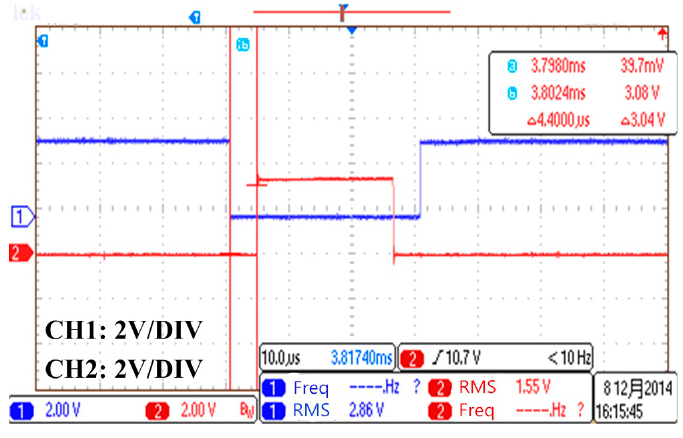
Figure 20. Dead time.